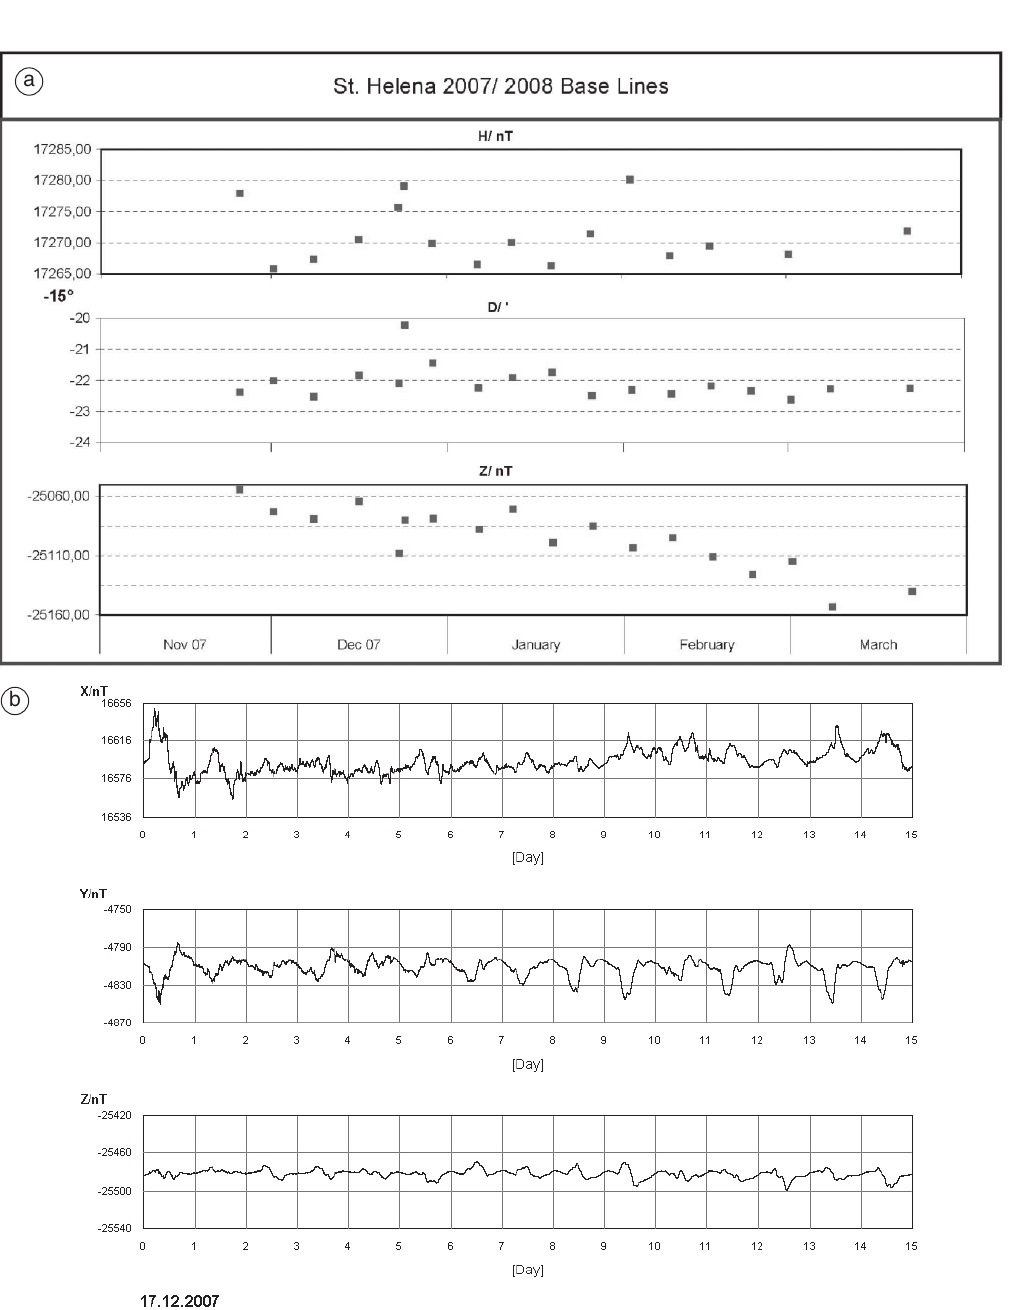
Fig. 10a,b. Expamples for data from STH observatory. a) Measured (black dots) baselines for November 2007 to January 2008. The scatter of the first measurements will be reduced as the observer gains experience. b) One minute values of the north (X), east (Y) and vertical (Z) component for the time interval December 17 to 31,